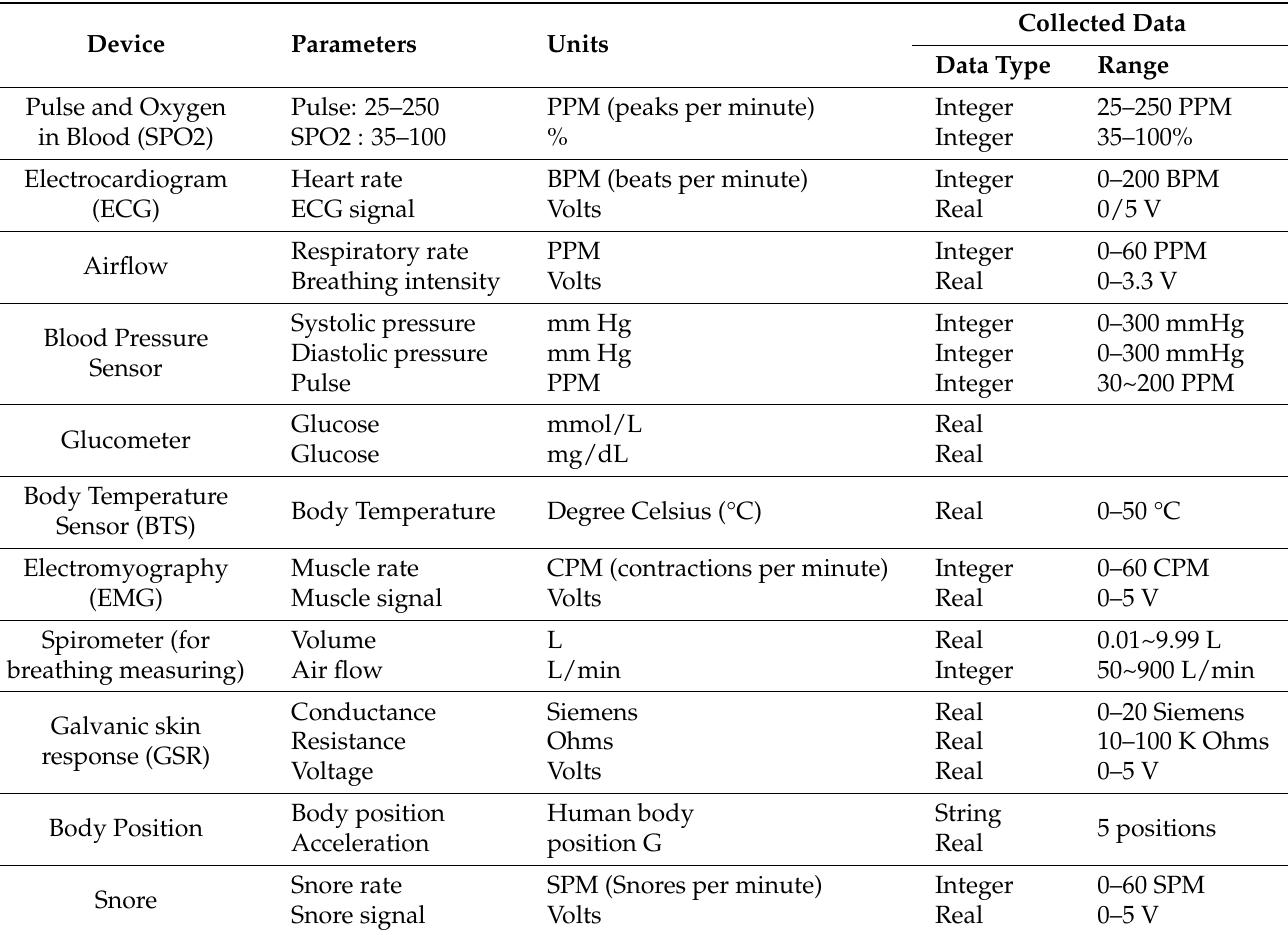
Table 9. Medical sensors